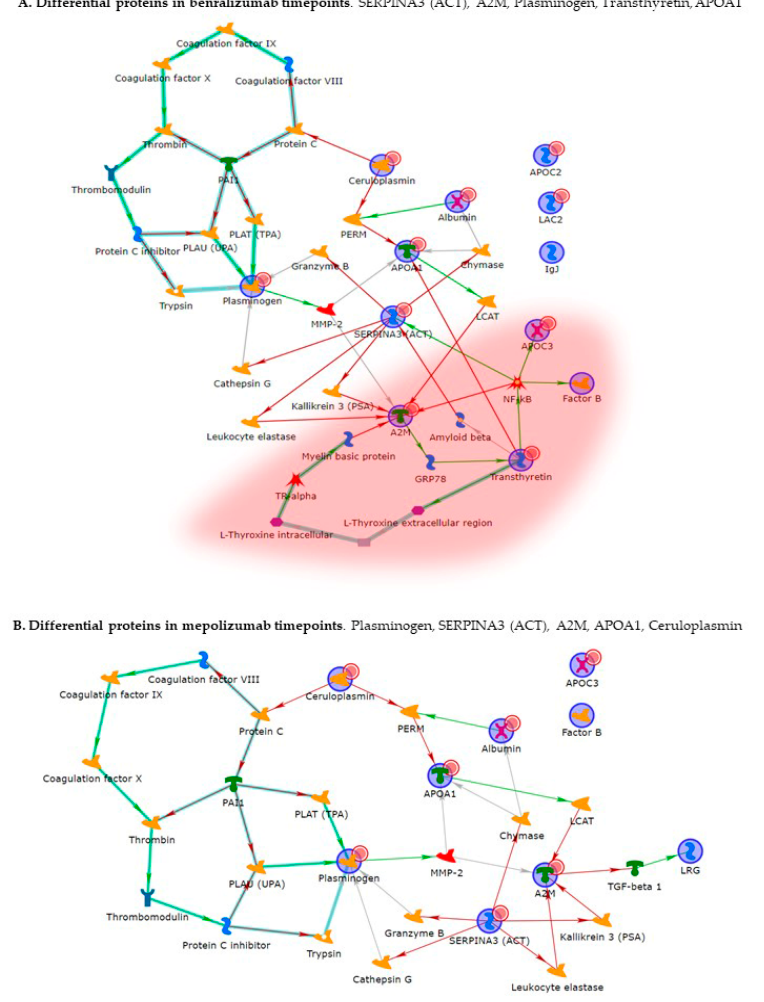
Figure 5. MetaCore analysis. ( A ) Network related to the differential proteins in benralizumab time points (T0, T1B, T6B). ( B ) Network related to the proteins in mepolizumab time points (T0, T1M, T6M). Red circle indicates the canonical pathway involving transthyretin, which was found differential only in benralizumab time points analysis. Statistical significance of protein interaction was p ≤ 0.001.